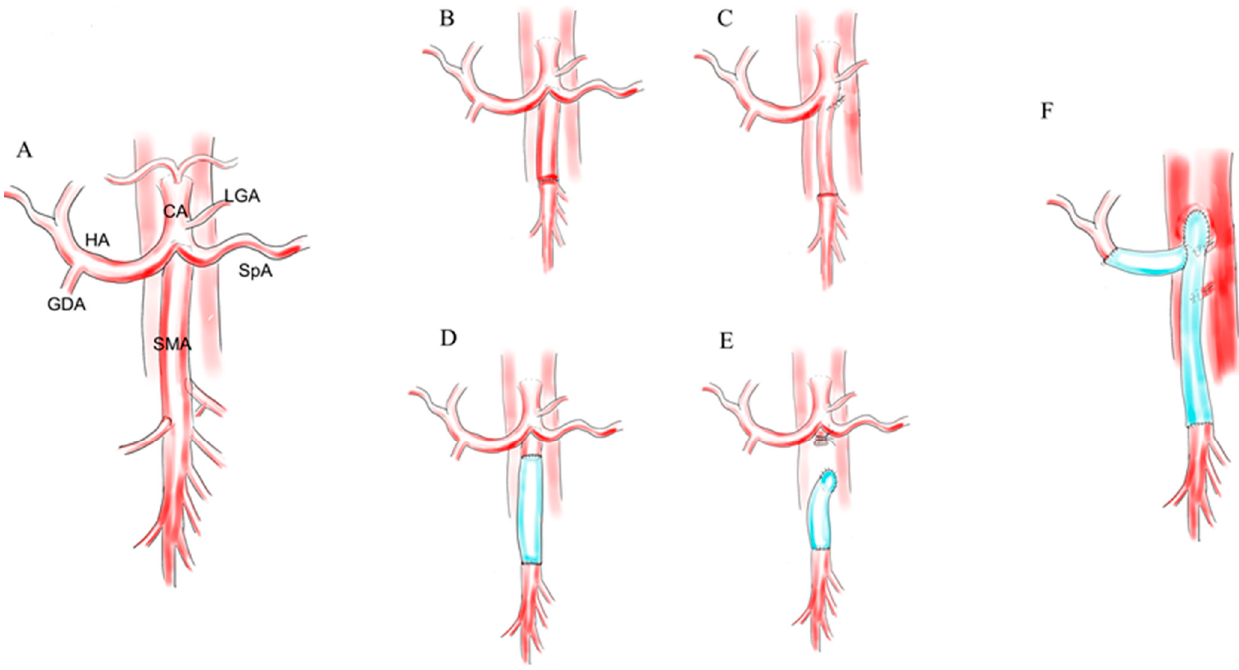
Figure 1. Reconstruction of the superior mesenteric artery. ( A ) Basic anatomy of relevant vessels in SMA resection. ( B ) Direct end-to-end anastomosis. ( C ) Transposition of SpA to be anastomosed with the distal stump of the SMA. ( D ) End-to-end anastomosis with graft interposition. ( E ) Graft interposition from the aorta to the distal stump of the SMA. ( F ) Combined resection and reconstruction of the HA and SMA using interposition grafts. HA, hepatic artery, SpA, splenic artery, GDA, gastroduodenal artery, SMA, superior mesenteric artery, MCA, middle colic artery and LGA, left gastric artery.